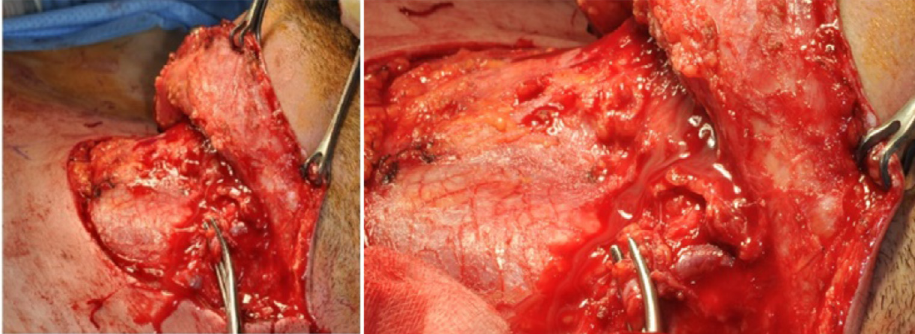
Fig. 4. Cervicotomy with purulent discharge and presence of necrotic tissue.